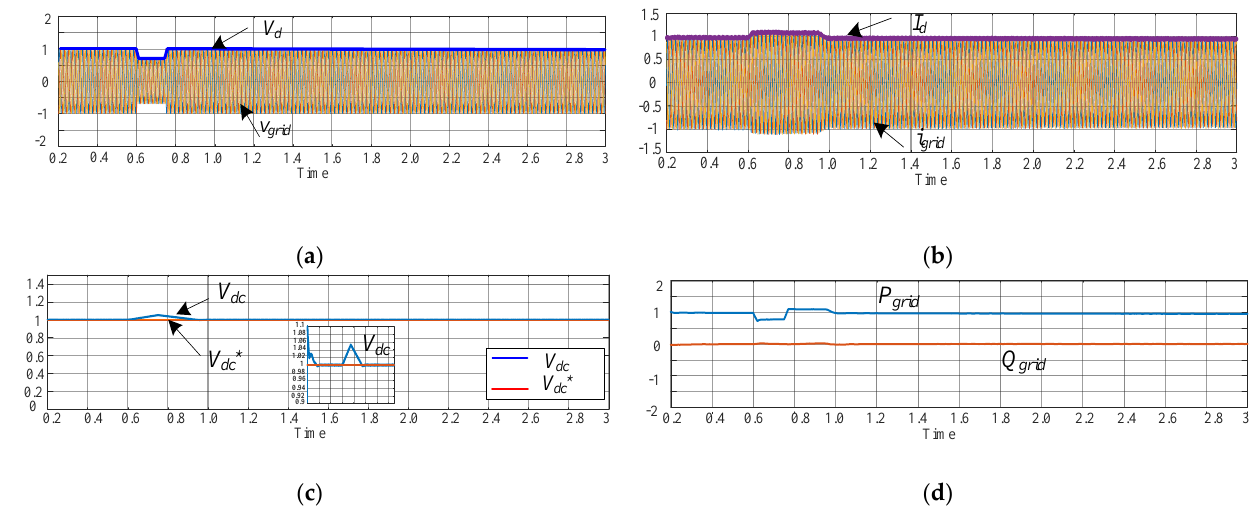
Figure 9. Simulation results during 30% symmetrical grid voltage dip without the proposed control scheme: ( a ) abc grid voltages 𝑣 𝑔𝑟𝑖𝑑 and d– axis grid voltage 𝑉 𝑑 (p.u.); ( b ) abc grid currents 𝑖 𝑔𝑟𝑖𝑑 and d– axis grid current 𝐼 𝑑 (p.u.); ( c ) DC– link voltage 𝑉 𝑑𝑐 and reference 𝑉 𝑑𝑐∗ (p.u); ( d ) grid active power 𝑃 𝑔𝑟𝑖𝑑 and reactive power 𝑄 𝑔𝑟𝑖𝑑 (p.u).